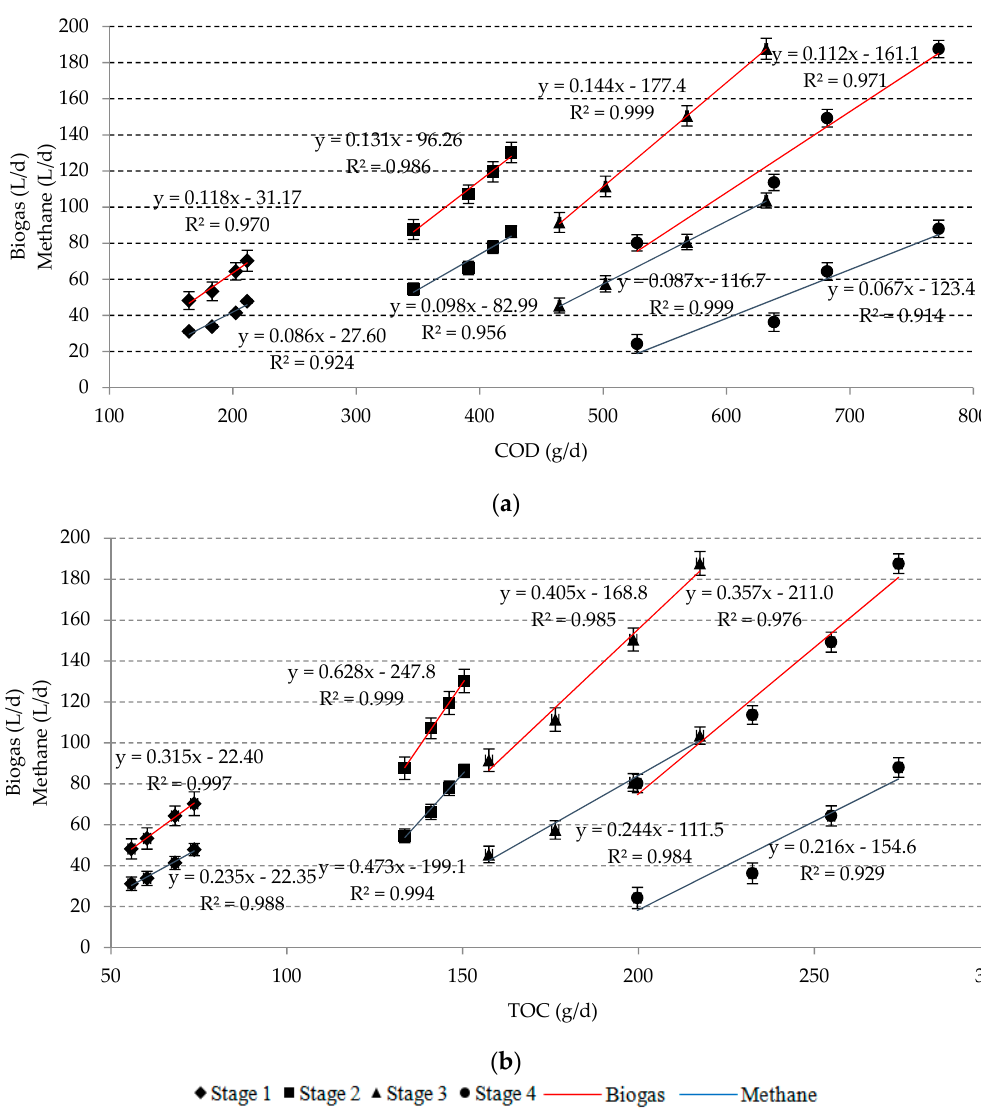
Figure 5. The relationship between biogas and methane production and organic compounds’ removal ( a ) as COD, ( b ) as TOC.